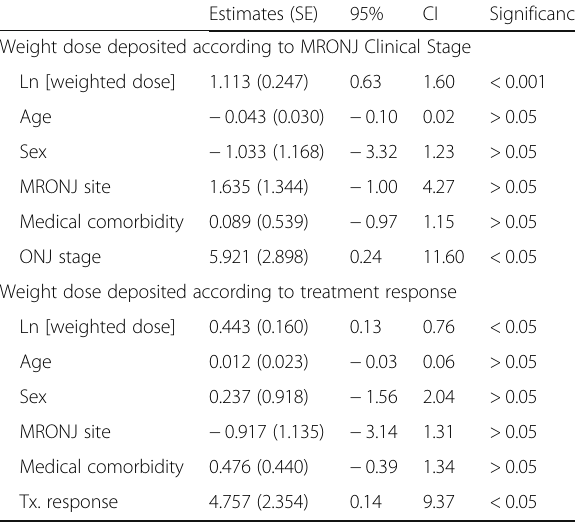
Table 4 Weight dose deposited according to MRONJ Clinical Stage and Treatment